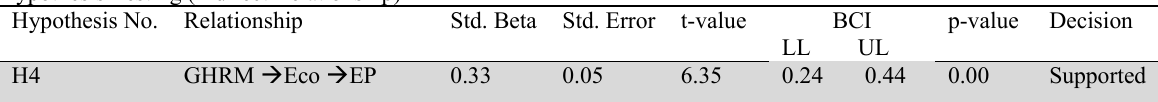
Hypothesis Testing (Indirect Relationship) Hypothesis No. Relationship Std. Beta Std. Error t-value BCI p-value